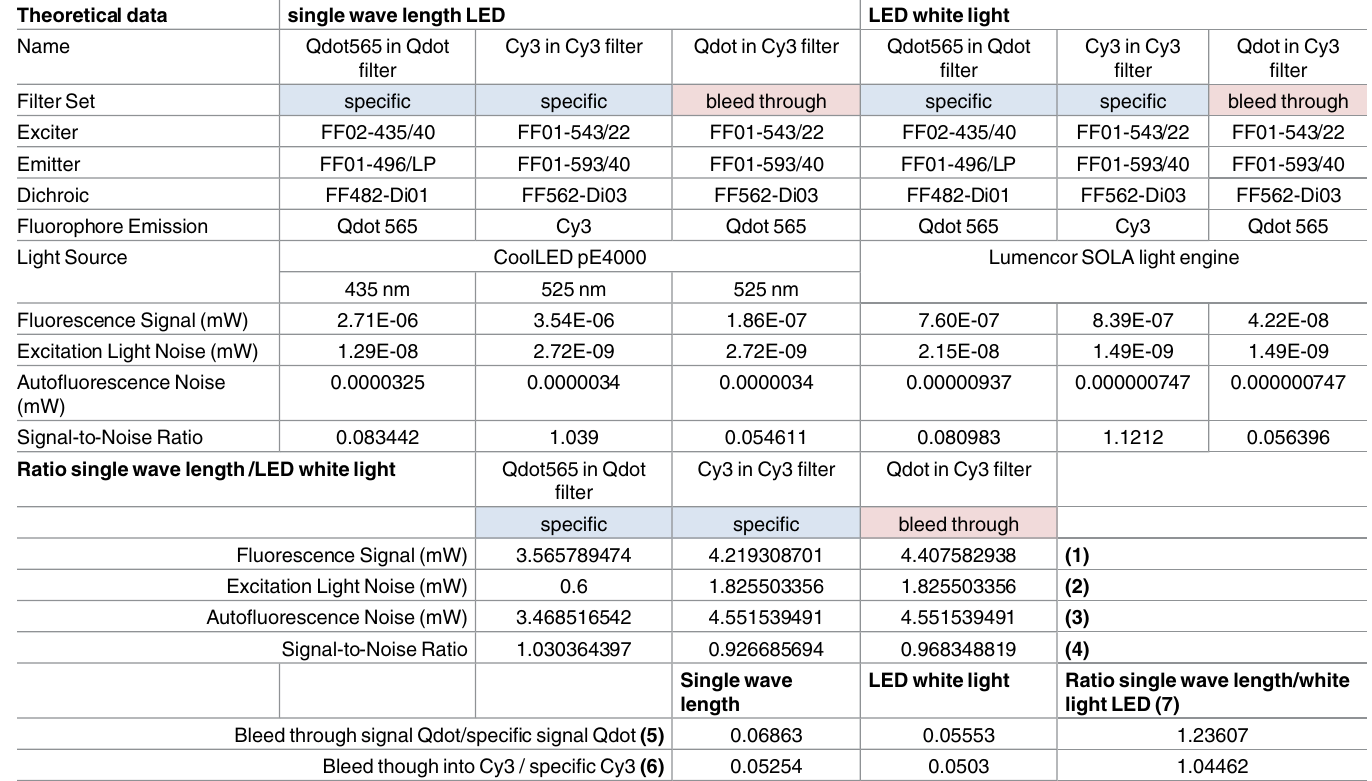
Table 8. Theoreticalbleed throughfor Qdot565 in Cy3 filter, usingsemrocksearchlight.com. Theoretical